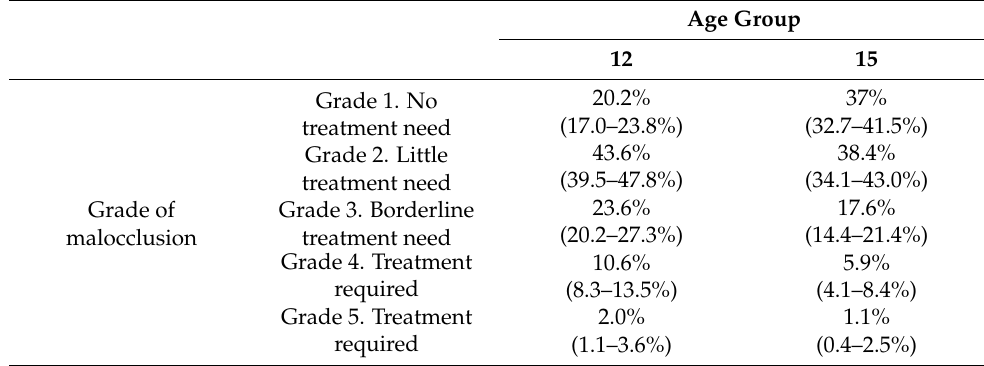
Table 2. Sample distribution in the different malocclusion grades, according to IOTH-DHC, at 12 and 15 years old (CI 95%).